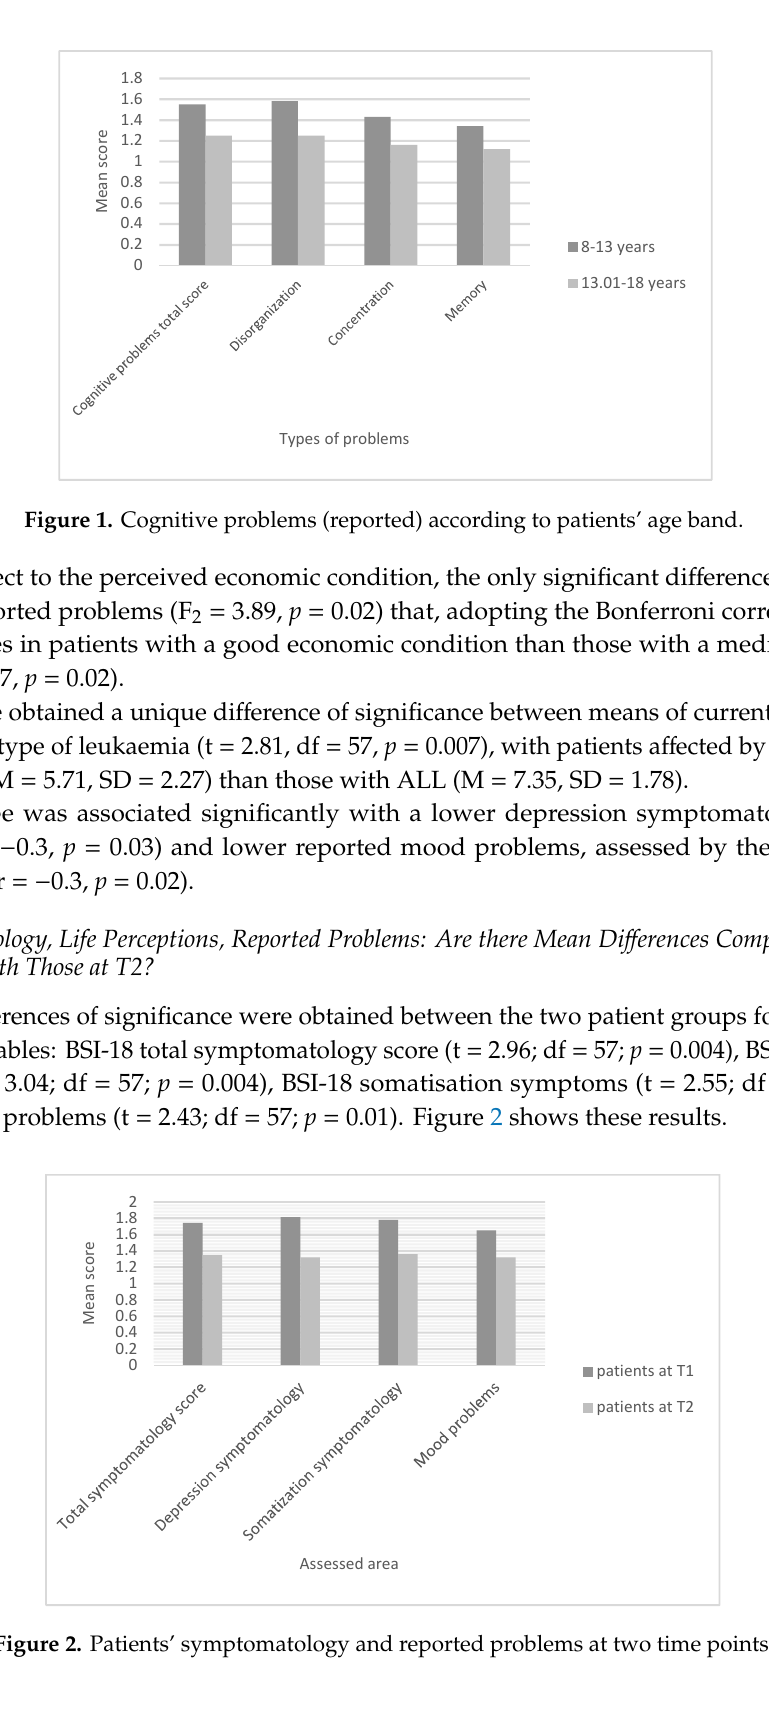
( b ) Figure 3. Mean differences of significance comparing patients and healthy peers regarding life perceptions ( a ), symptomatology and reported problems ( b ). Healthy peers reported BSI-18 anxiety higher scores comparing with patients’ scores (t = −3.9; df = 58; p = 0.0001) and likewise for total cognitive problems (t = −3.67; df = 58; p = 0.001). Specifically, problems reported as higher in the control group were impulsivity (t = −2.58; df = 58; p = 0.01), disorganisation (t = −3.12; df = 58; p = 0.003), concentration (t = −4; df = 58; p = 0.0001) and memory (t = −4.13; df = 58; p = 0.0001) (Figure 3b). 4. Discussion Despite the increase in survival rates, cancer applies a physical, social and psychological cost both for the adolescent patients and for their families. One of the challenges health professionals are required to respond to is helping patients maintain physical health and psycho-social wellbeing [29]. This study aimed to fill some gaps in the literature with respect to the implications at the psycho- social level within the first year after the communication of the leukaemia diagnosis, thus in both the acute and chronic phases of therapies.